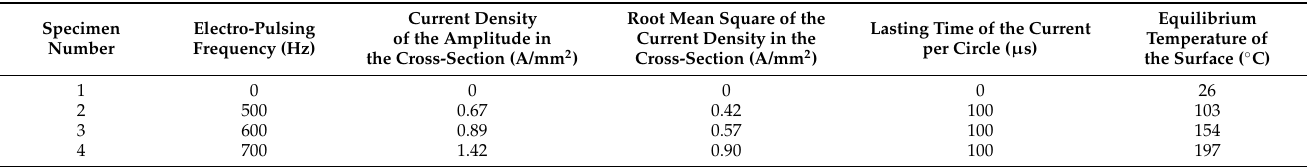
Table 4. Cutting parameters of CT and